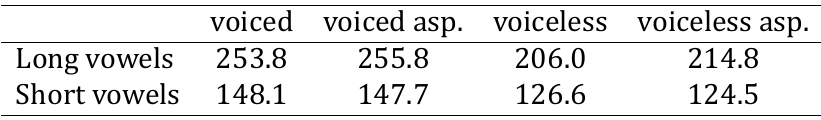
Table 1: Hindi vowel durations (ms), by following consonant